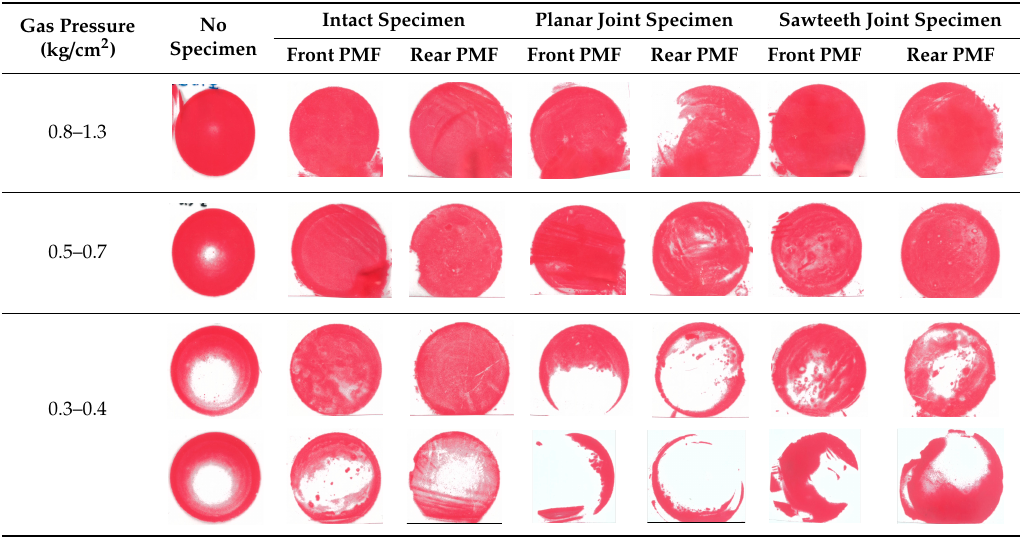
Figure 4. Average error ( e ε ) in early dynamic equilibrium state for all SHPB tests in this study. 210 of 311 specimens have e ε < 20%. Plot of e ε with gas pressure. Table 1. Illustration of red patches on pressure measurement films (PMFs) used between interfaces of embedded specimen and incident and transmitted bars in a SHPB test. Medium-pressure types are used except low-pressure type is used in the four on the right of the last row, with gray background. Gas